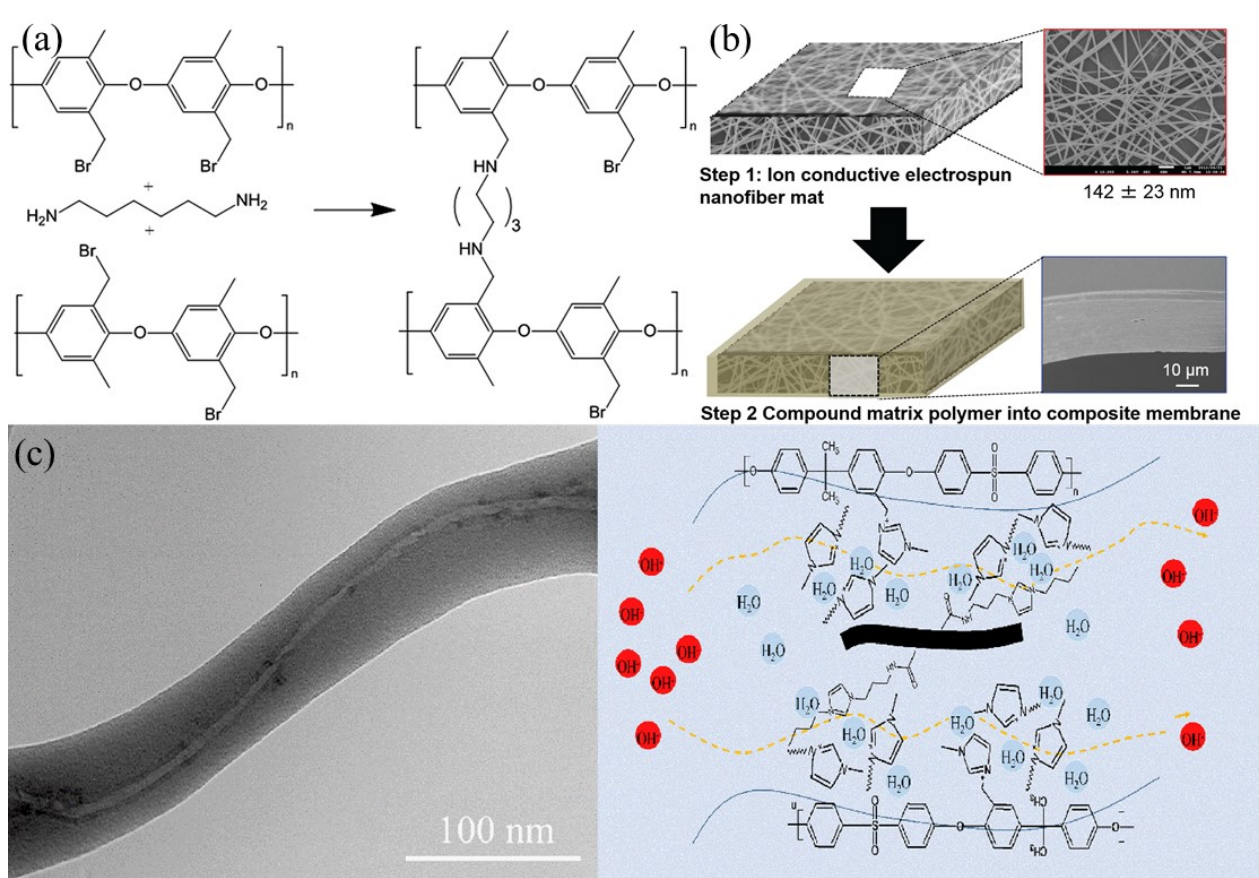
Figure 6. ( a ) Scheme for reacting brominated poly(phenylene oxide) with hexamethylenediamine crosslinker. Reproduced with permission from Ref. [70]. ( b ) Fabrication process for making a composite membrane with QPAES nanofibers. Reproduced with permission from Ref. [71]. ( c ) TEM image of an MWCNT-embedded in an electrospun nanofiber and a possible mechanism of hydroxide transport in a MWCNT/IMPS co-electrospun composite membrane. Reproduced with permission from Ref. [72].